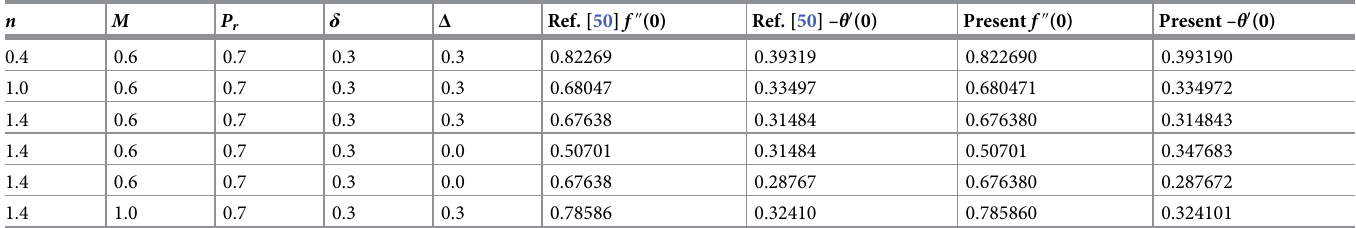
Table 2. Comparison values of f @ (0) and – θ 0